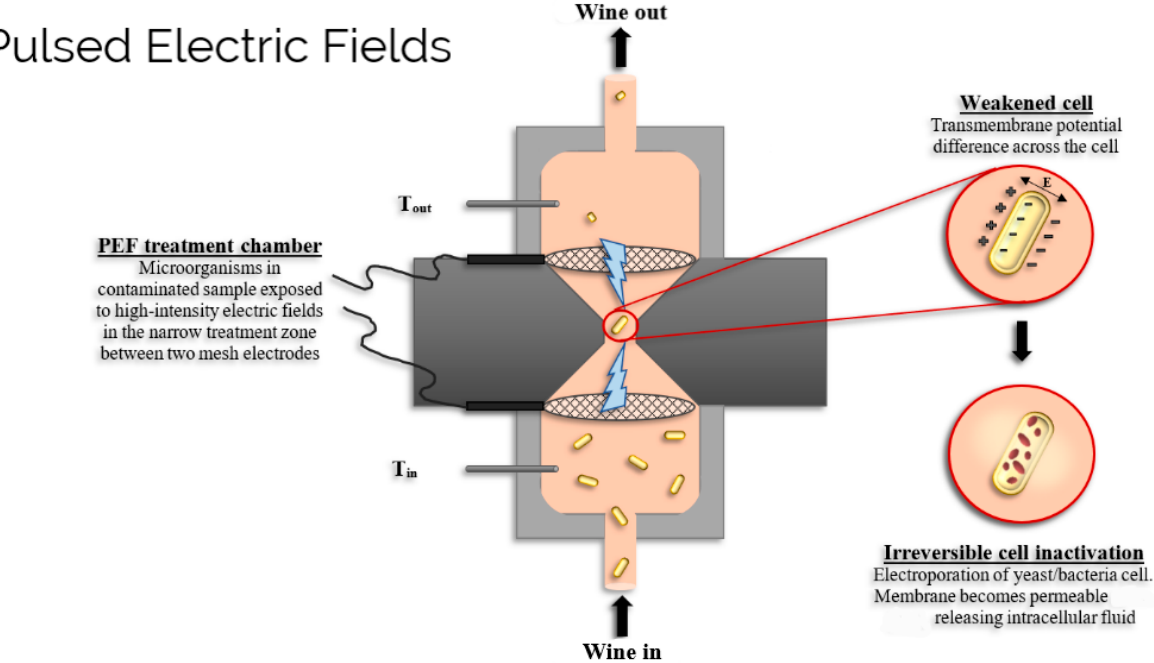
Figure 1. Diagram showing the pulsed electric field (PEF) inactivation of wine spoilage microorganisms (T refers to temperature which is below 40 ◦ C for a non-thermal